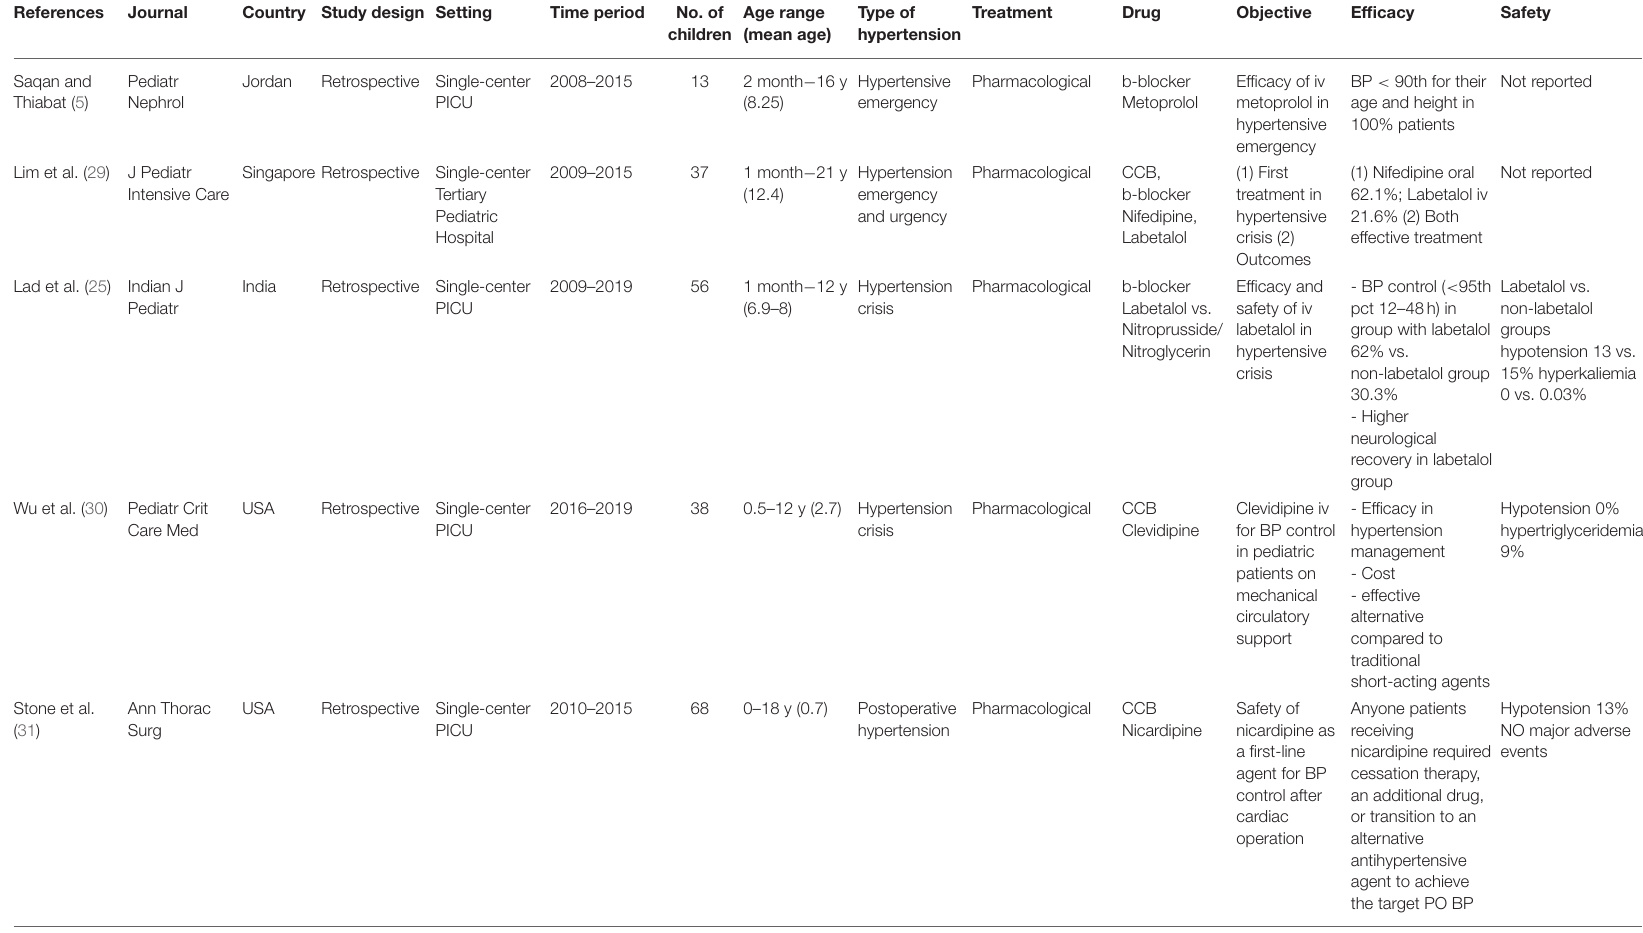
TABLE 1 | Studies meeting inclusion criteria and their